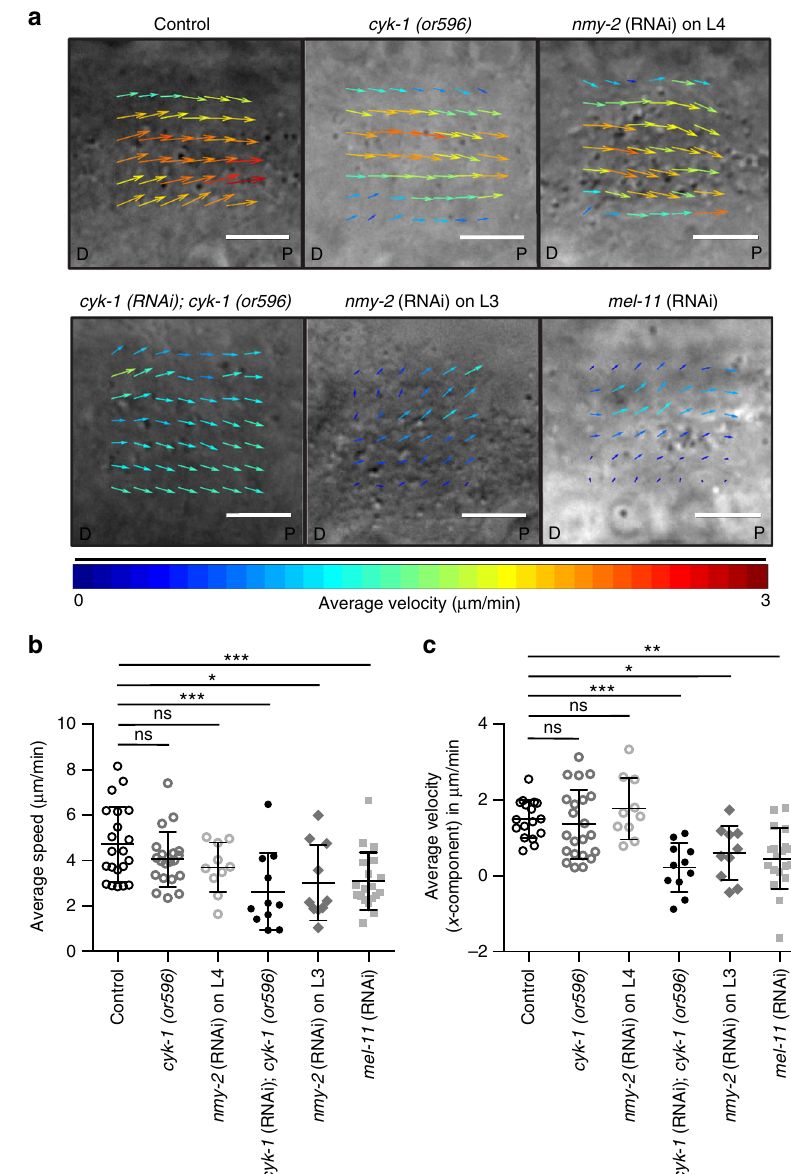
Fig. 5 Loss of actomyosin regulators results in reduced cytoplasmic streaming. a Representative images of the average velocity vectors (PIV analysis) of the cytoplasmic streaming in the distal region of control, cyk-1(or596) at 20 °C, nmy-2 (RNAi) on L4 stage worms, cyk-1 (RNAi) on cyk-1(or596) , nmy-2 (RNAi) on L3 stage worms, and mel-11 (RNAi) gonads. Images are oriented in the direction of distal (D) to proximal axis (P) of the gonad. b , c Average speed and average velocity of the cytoplasmic streaming (along the X -axis) in the distal region of control ( N = 17), cyk-1(or596) at 20 °C ( N = 22), nmy-2 (RNAi) on L4 stage worms ( N = 10), cyk-1 (RNAi) on cyk-1(or596) ( N = 11), nmy-2 (RNAi) on L3 stage worms ( N = 10), and mel-11 (RNAi) gonads ( N = 19). The particle speed and velocity was analyzed for 200 s in each movie. Data represents mean ± s.d. of four independent experiments. Statistical analysis was done using one-way ANOVA test (* p < 0.05, ** p < 0.005, *** p < 0.0001, ns, non-signi fi cant), N = number of gonads analyzed. Scale bar, 5 µ